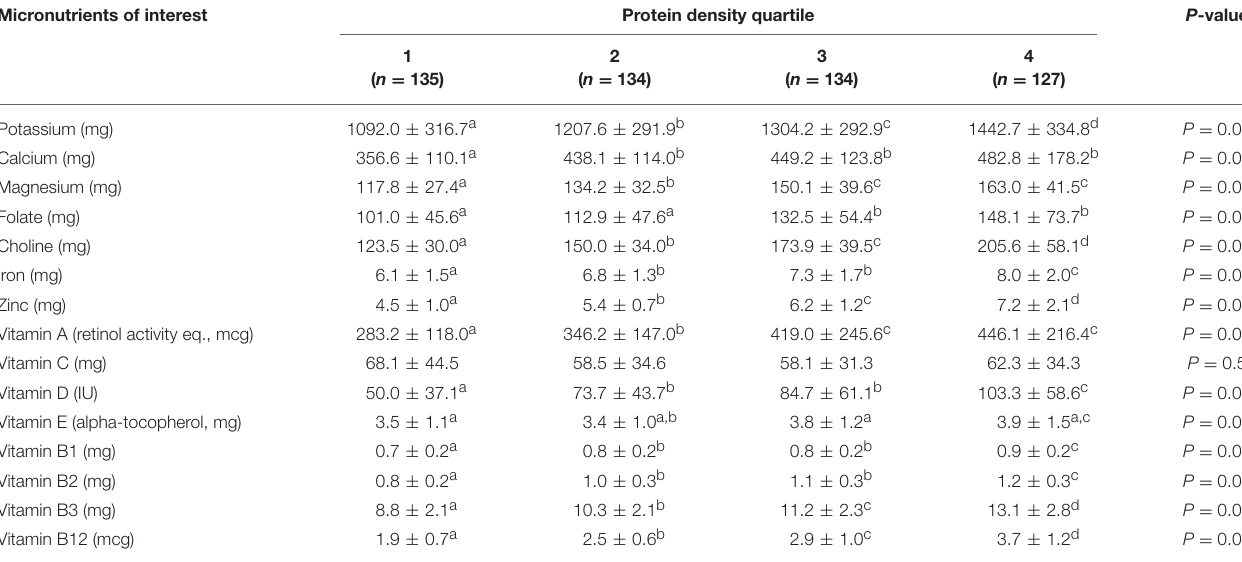
TABLE 4 | Estimated daily micronutrient intakes across protein density quartile in healthy young adults 1, 2 . Micronutrients of